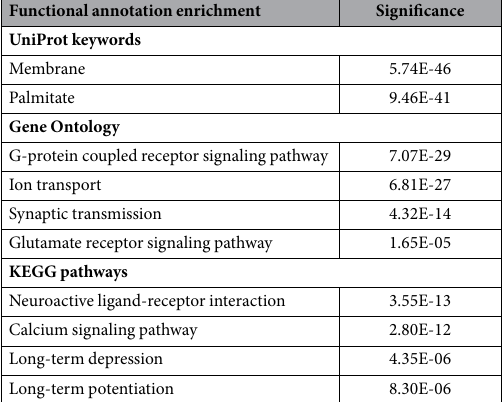
Table 2. Functional annotation of the brain palmitoyl-proteome. Enrichment of UniProt keywords, Gene Ontology terms and Kegg pathways in the brain palmitoyl-proteome was performed. Significance of enrichment was calculated by Fisher’s exact testing (benjamini Hochberg FDR